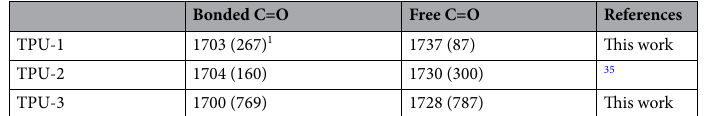
Bonded C=O Free